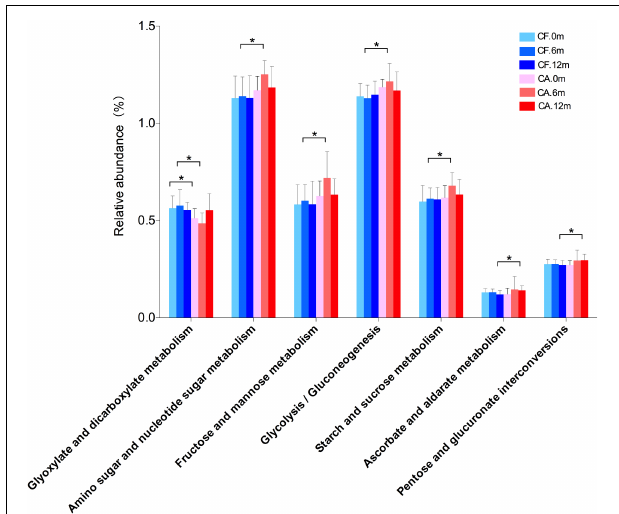
FIGURE 7 | Comparison of carbohydrate metabolisms in supragingival microbiome between CF and CA groups. Differences in carbohydrate metabolism were analyzed using LEfSe analysis. The bars represent “mean ± SD” relative abundances. ∗ P <